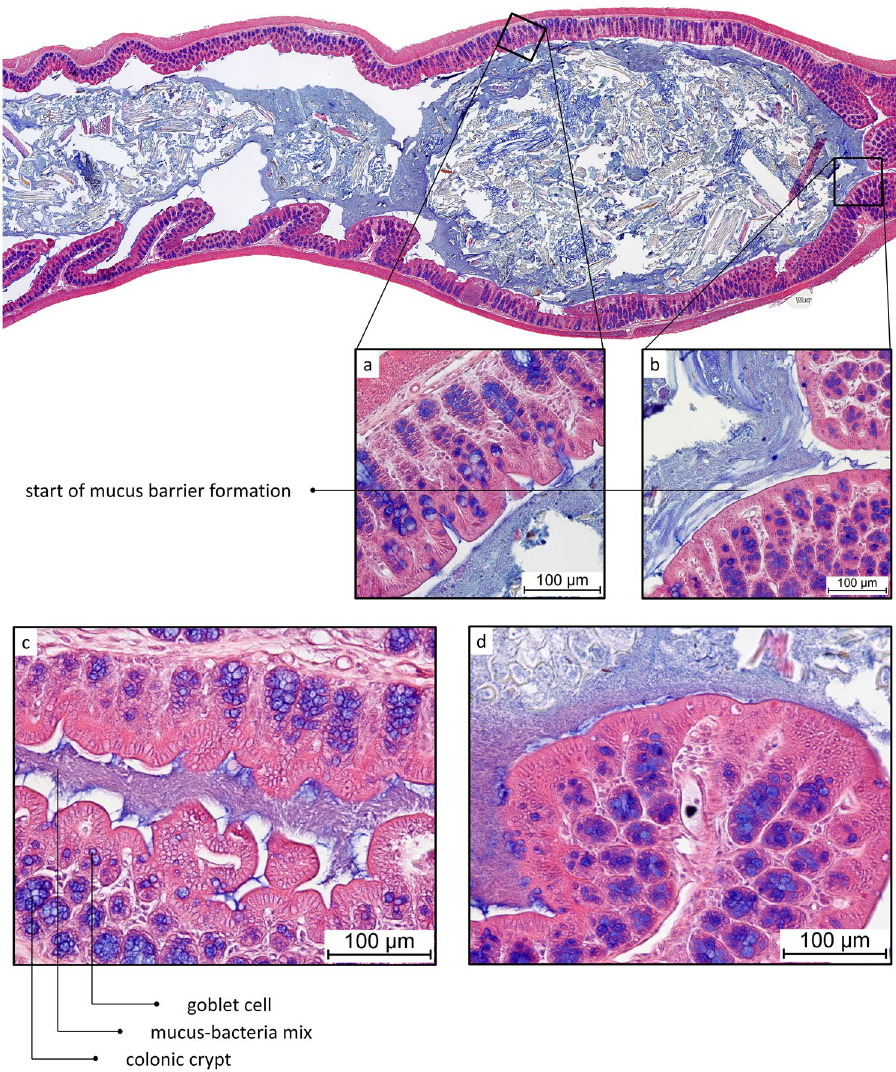
Figure 7. AB/H/E stained longitudinal section of mouse proximal colon. Proximal side of tissue on the left, distal on the right. ( a ) Close-up of proximal part of newformed pellet. ( b ) Close-up of distal part of newformed pellet. ( c ) AB/H/E stained longitudinal section of mouse proximal colon. No mucus layer separates bacteria from epithelium. ( d ) AB/H/E stained longitudinal section of mouse proximal colon. No mucus layer separates bacteria from